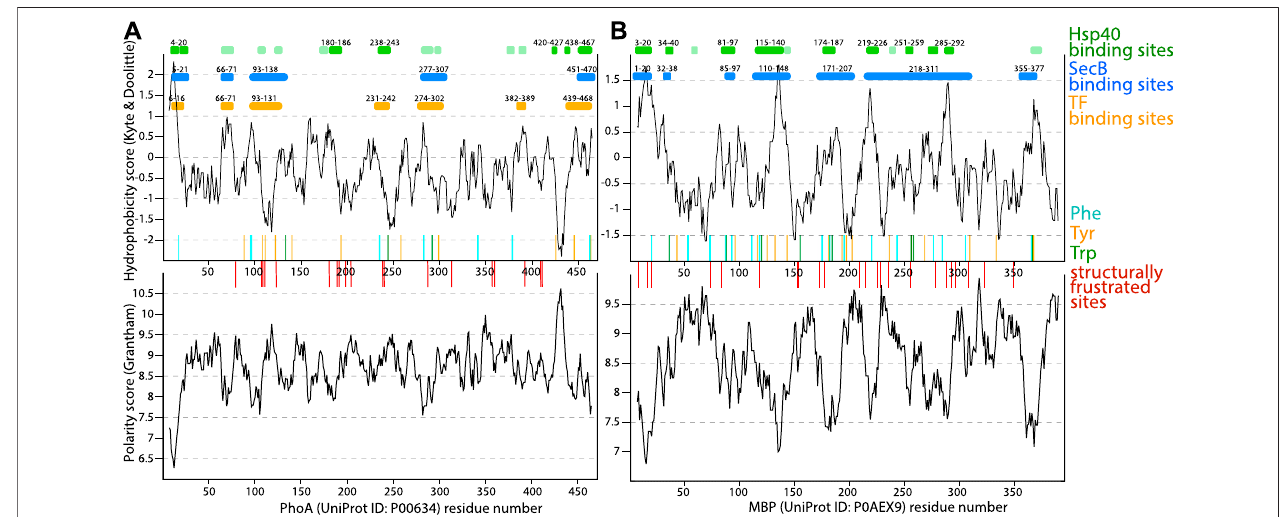
FIGURE7| PropertiesofthemodelclientproteinsalkalinephosphataseA(PhoA)andmaltose-bindingprotein(MBP). (A) Plotofhydrophobicity (upperpanel) and polarity (lowerpanel) ofPhoAasafunctionofitsresiduenumber. Sameasfortheplotsshownpreviously,plotswereobtainedwithExpasyProtScalebioinformatictool (window size 13). (B) Hydrophobicity (upper) and polarity (lower) plots of MBP as a fuction of its residue number. In orange colored bars, experimentally determined binding site of TF chaperone on PhoA client protein are shown Saio et al. (2014). Binding sites of SecB chaperone Huang et al. (2016) and of Hsp40 chaperone Jiang et al.(2019) on PhoA and MBP are shown with blue and green colored bars, respectively. For each client protein, position ofaromatic residues (Phe in cyan, Tyr in orange and Trp in green) are indicated on the plots, along with the position of structurally frustrated residues (in red). Measuring ofhow favorable a particular amino-acid contact is in the protein structure was calculated with Frustratometer Server Ferreiro et al. (2014) where contacts with frustration index < − 1 were classi fi ed as highly frustrated and indicated in this fi